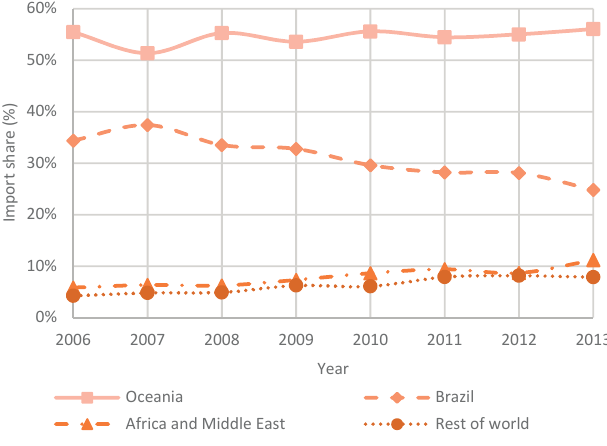
Figure 7. Asian iron ore import share split into major supply regions